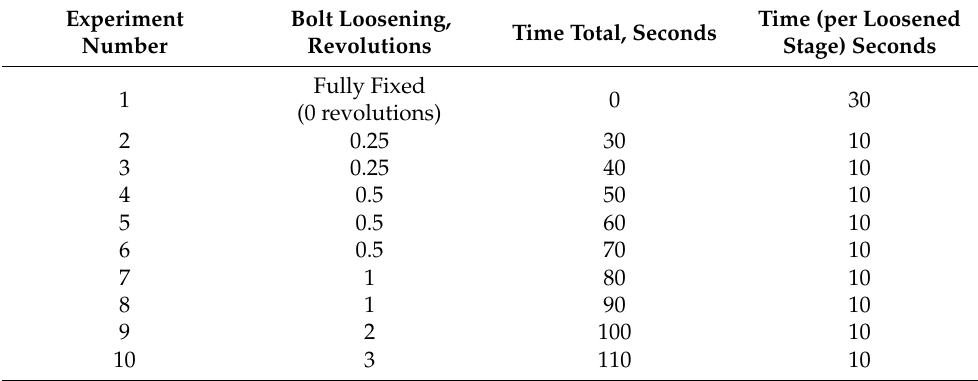
Table A2. Experimental bolt-loosening progression experiment